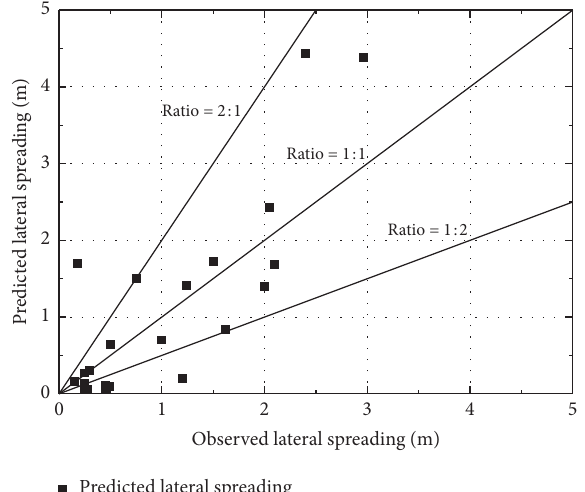
Figure 6: The relationship between the residual shear strength ratio and the equivalent clean sand corrected SPT blow